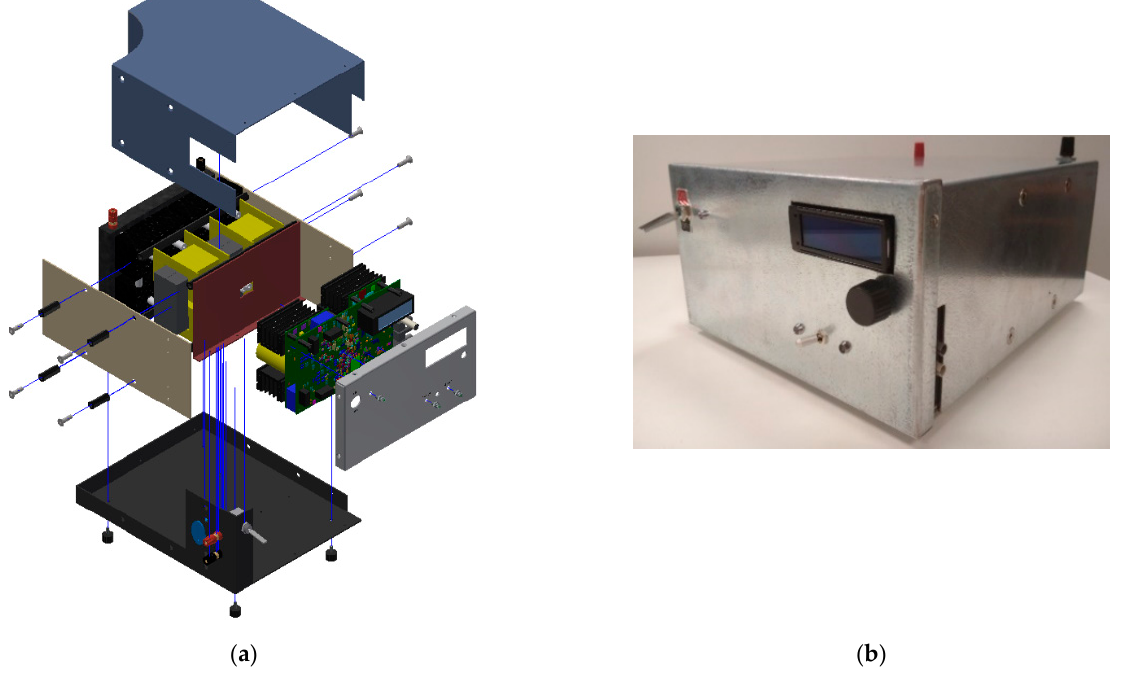
Figure 11. CAD drawing of the developed power supply ( a ) and photo of the finalized prototype ( b